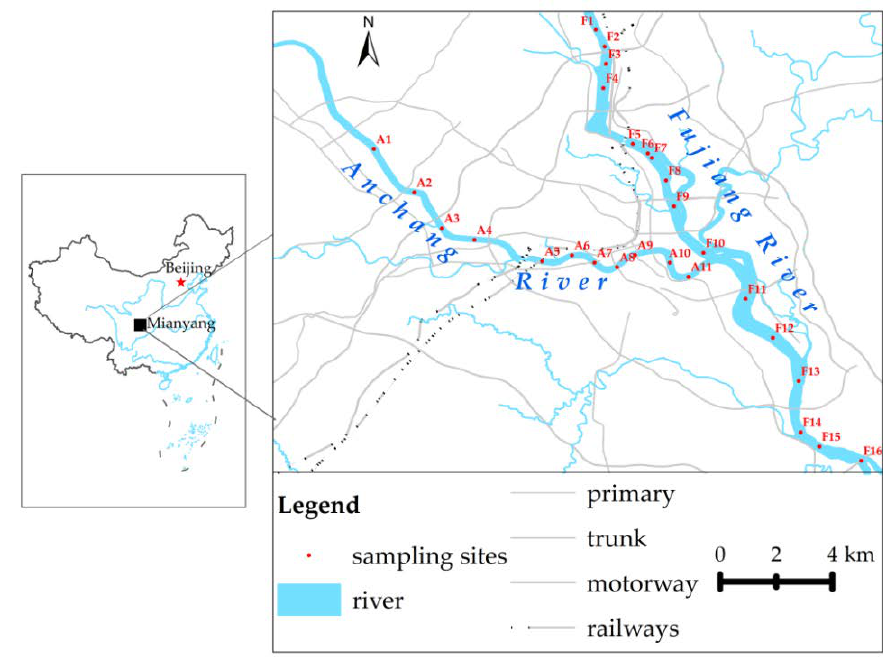
Figure 1. Sediment sampling sites in the Mianyang section of the Fujiang River.